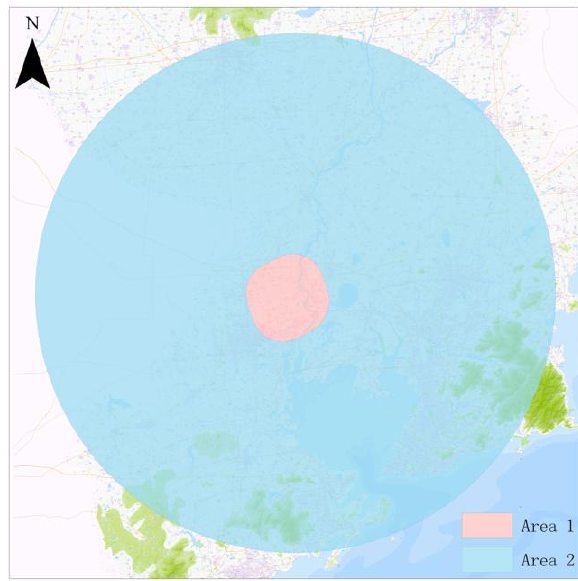
Figure 2. Obstacle limitation surface areas of QT airport